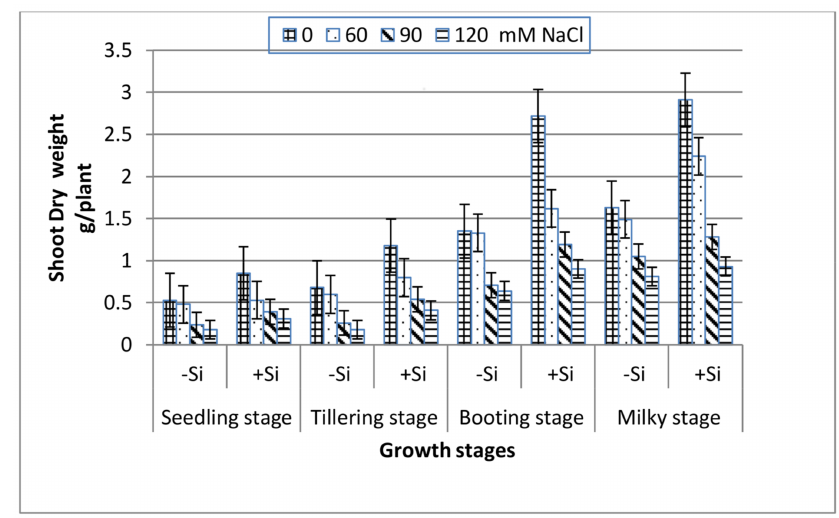
Figure 2. Effect of NaCl on the shoot dry weight of wheat at different growth stages in the presence and absence of silicon.